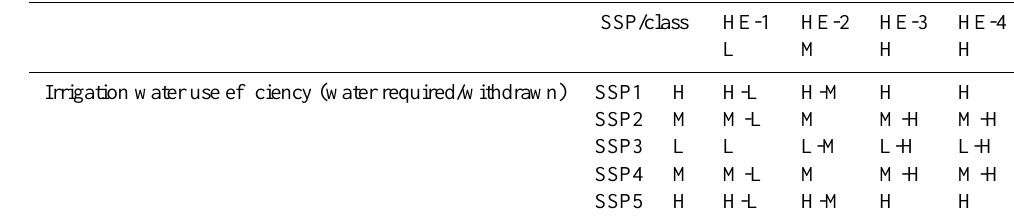
Table A13. Water dimension – irrigation water use efficiency assumptions.